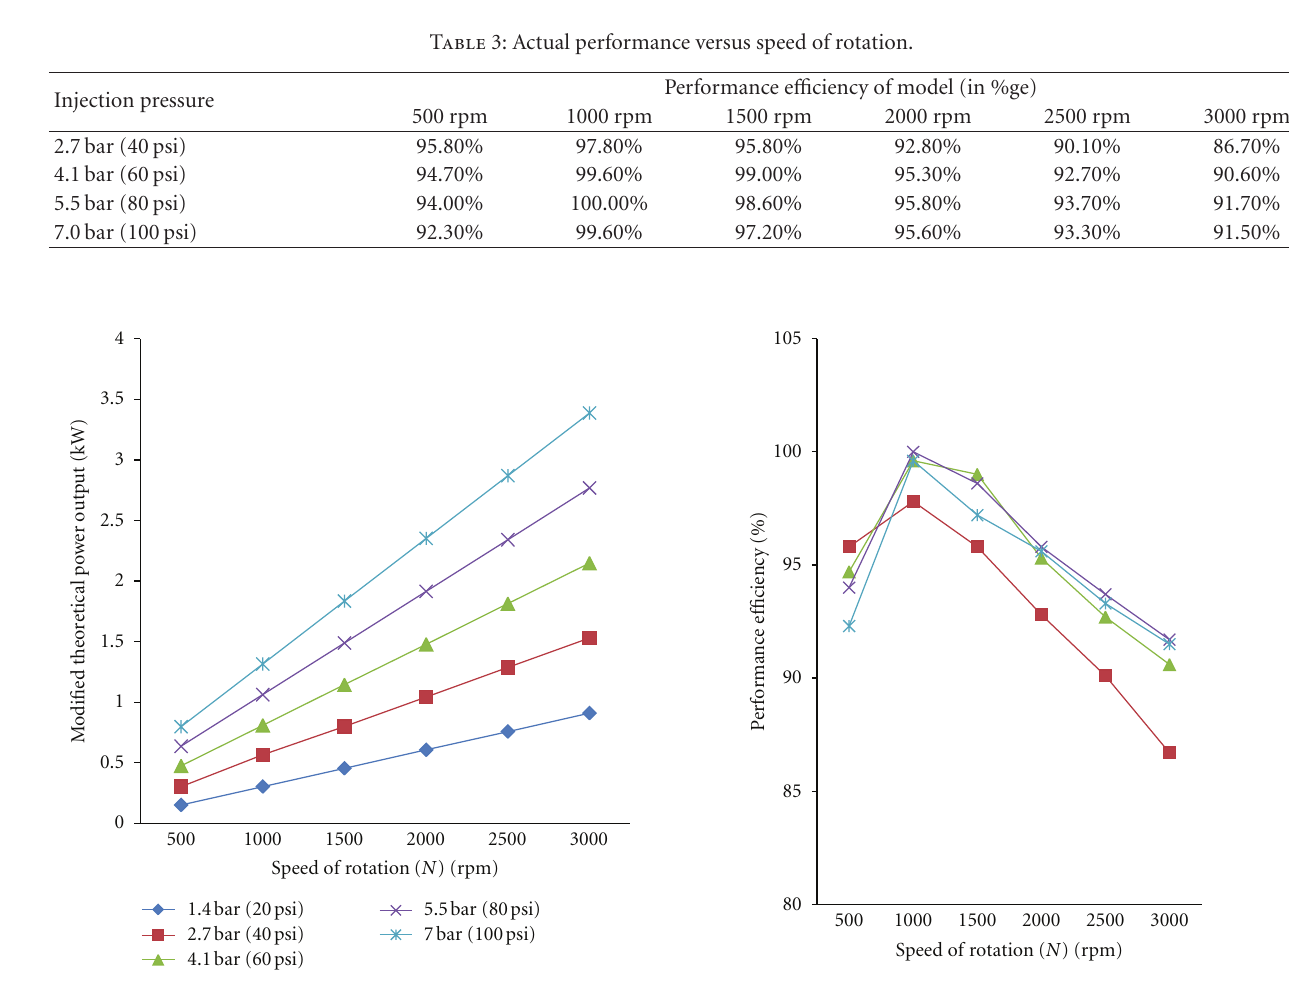
Figure 12: Modified theoretical power output ( W total-modified ) versus speed of rotation.